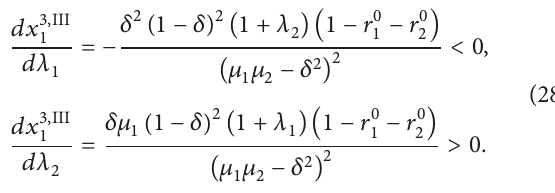
Figure 2: The changes of equilibrium share of player 1 as 𝜆 1 .